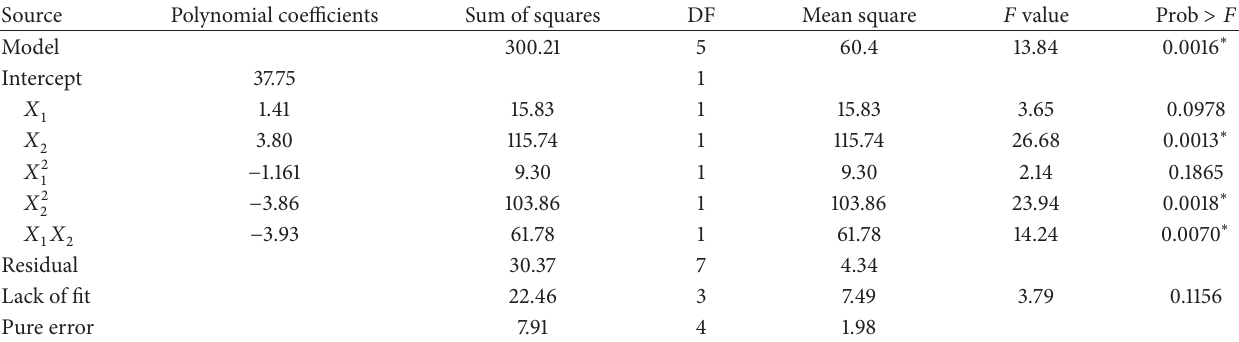
Table 5: Analysis of variance for the quadratic polynomial model of lipid content produced by Cunninghamella bainieri 2A1.